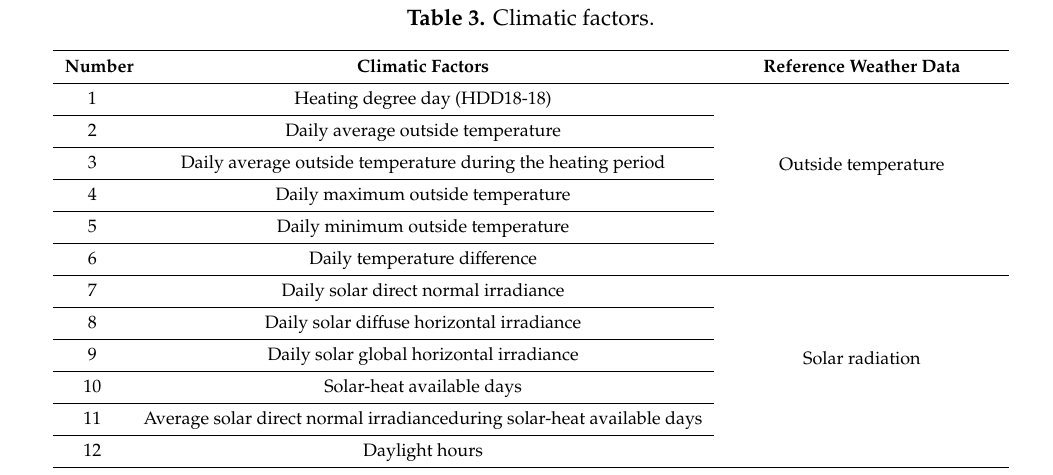
Table 5. Correlation analysis between elements (five items).